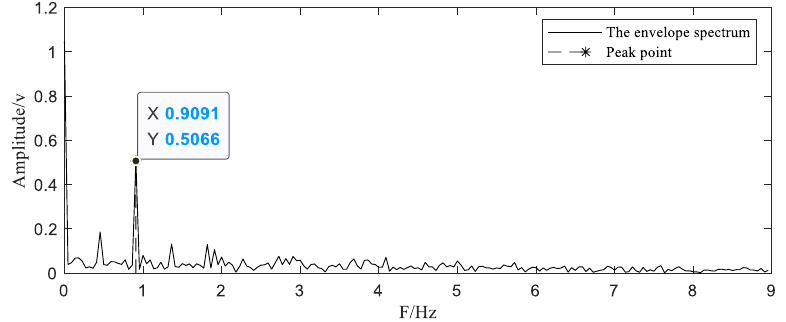
Figure 5. The envelope spectrum of the signal after resampling.